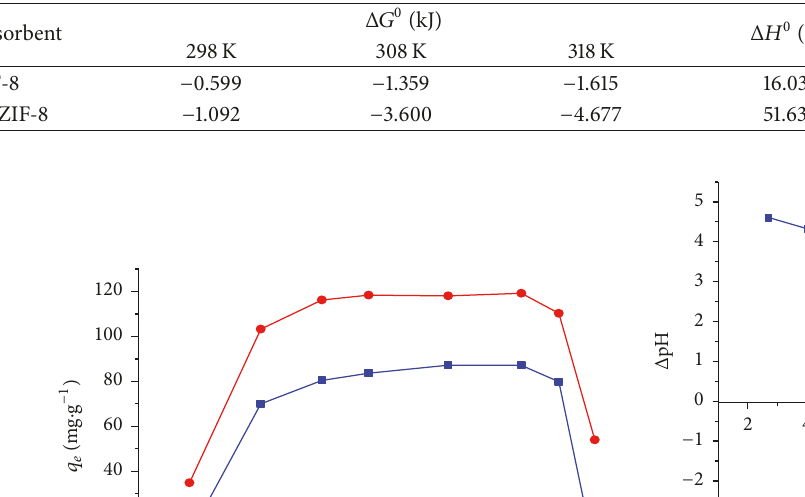
Table 8: Thermodynamic parameters for the adsorption of RDB dye onto ZIF-8 and Fe-ZIF-8.